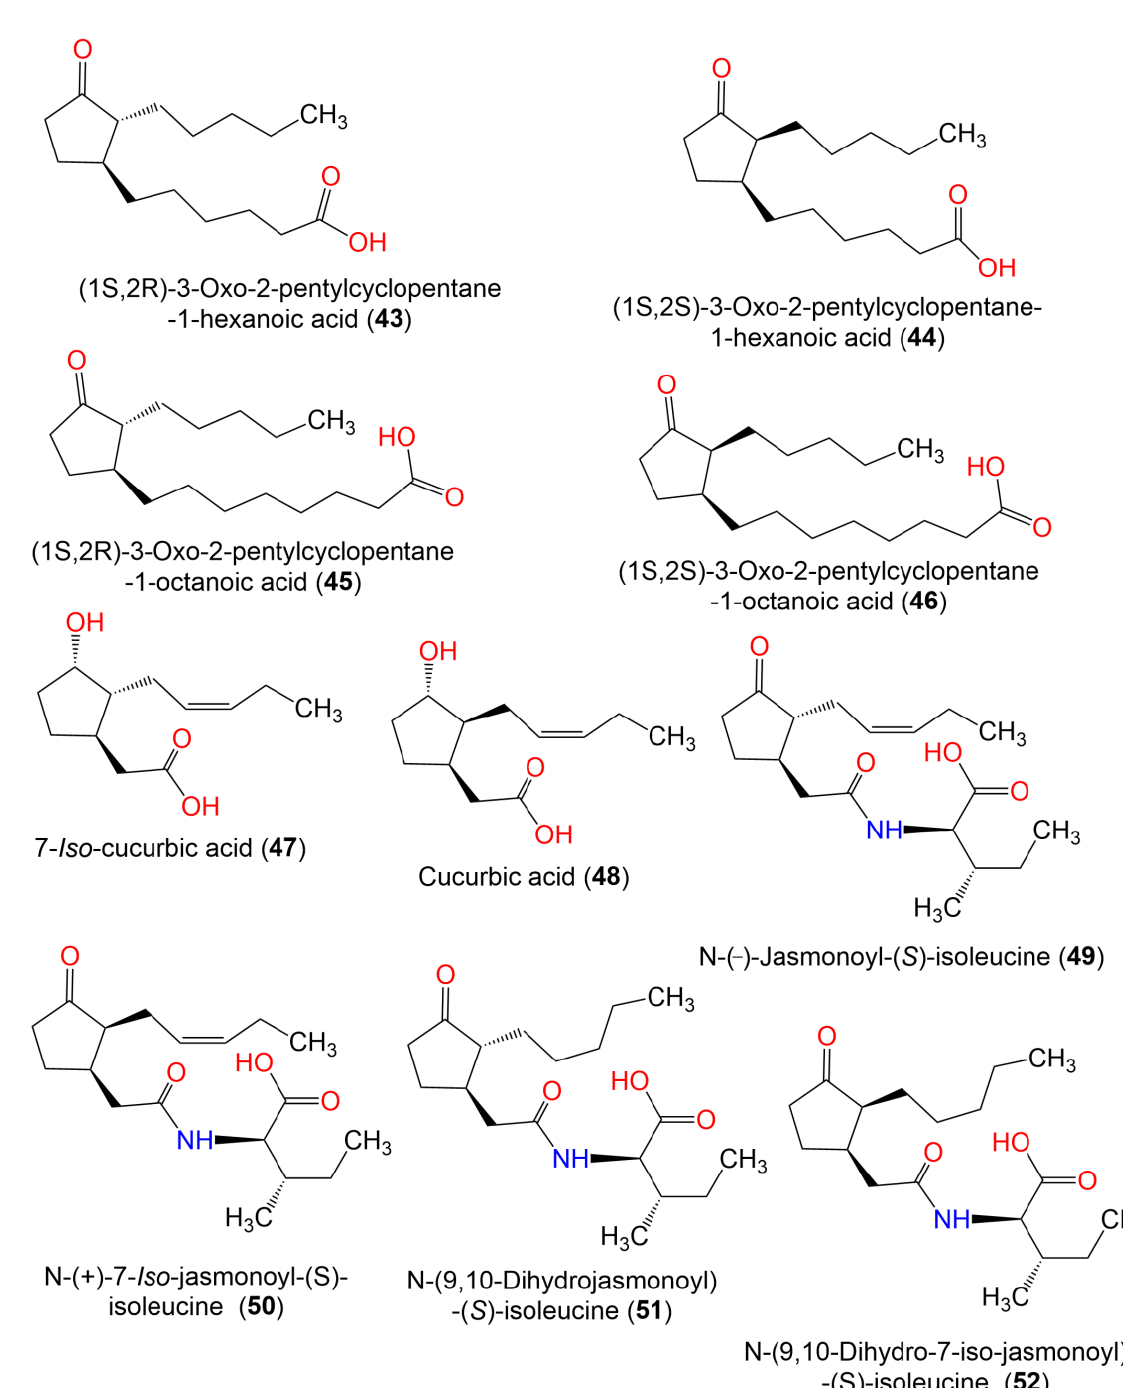
Figure 4. Structures of jasmonates derivatives ( 43 – 52 ) isolated from F. oxysporum .